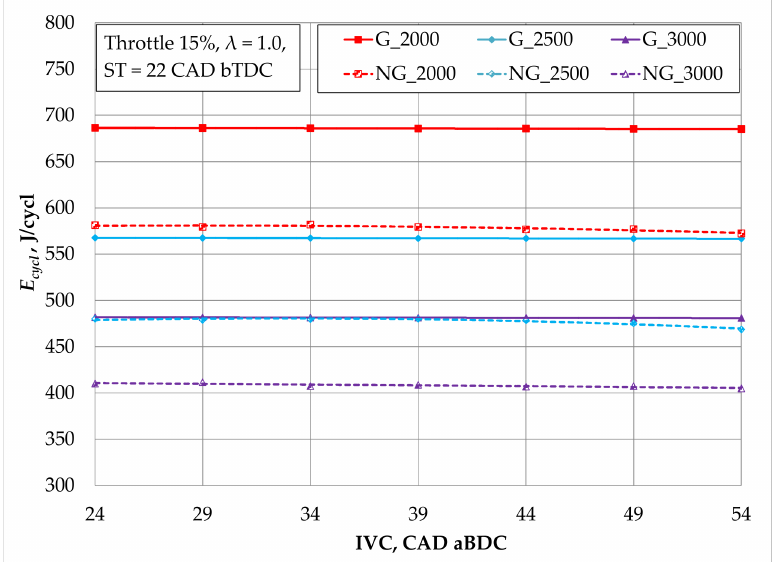
Figure 4. Fuel energy entering the cylinder during the cycle with the engine running on gasoline and natural gas and while changing the intake valve close